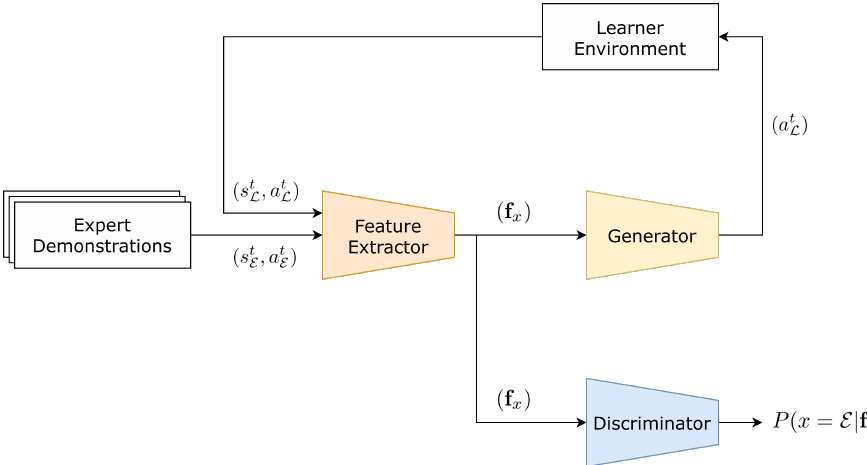
Figure 2. The architecture of the proposed DAIL-GAN